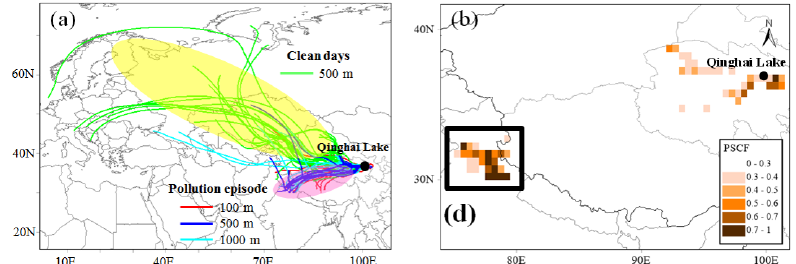
Figure 4. (a) Five-day backward air mass trajectories reaching Qinghai Lake at 100, 500, and 1000m above ground every 6h and (b) likely source areas of rBC identified using potential source contribution function (PSCF) plots during the entire campaign.